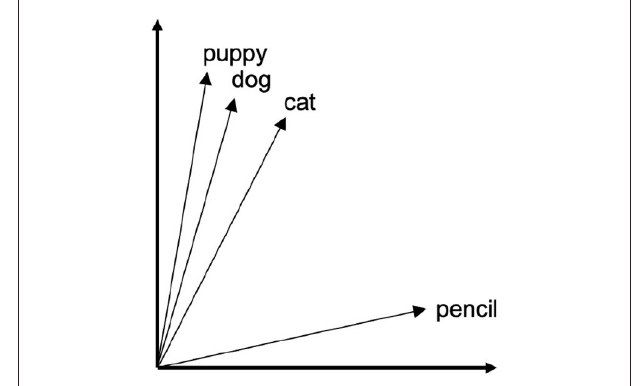
FIGURE 2 | Hypothetical vector space for four English